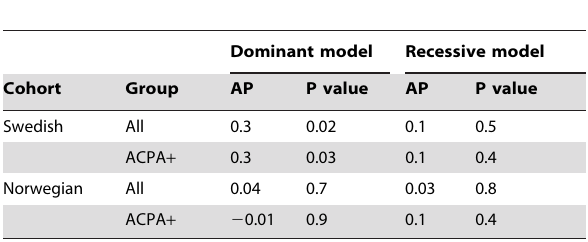
Table 3. Summary data for interaction analysis between CIITA rs4781019 and HLA-DRB1